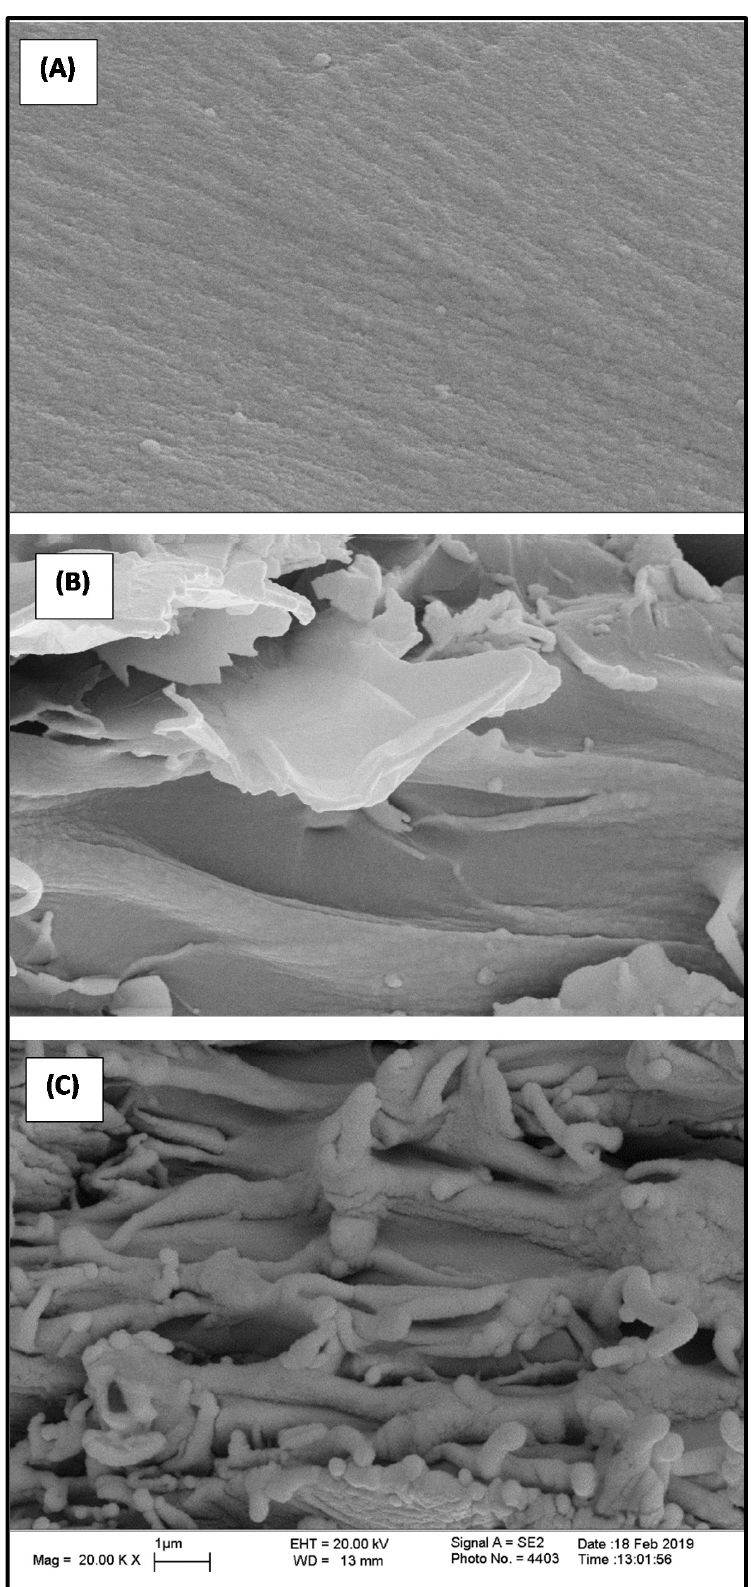
Figure 5. SEM micrographs of the fractured films: neat aramid ( A ); ArGr ( B ) and ArGrO ( C ) composites with 4 wt.% of graphene. with 4 wt.% of